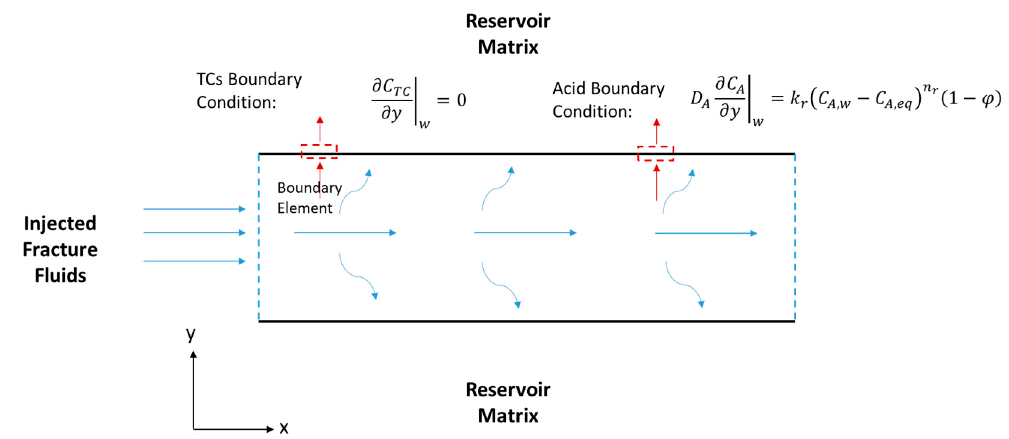
Figure 4. Schematic of a hydraulic fracture along the fracture length (x) and width (y), showing the acid and TCs’ BCs.